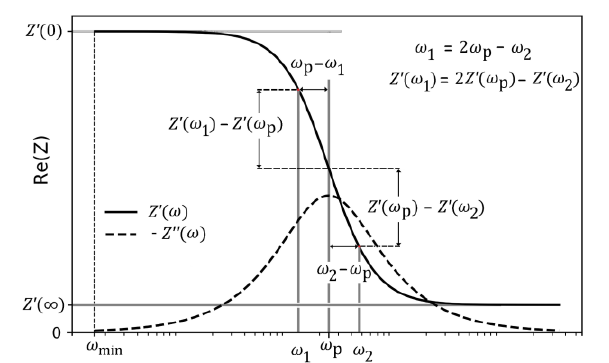
Fig.2: Frequency and amplitude of the interpolated points. 𝜔 𝑝 : central frequency of the dispersion.